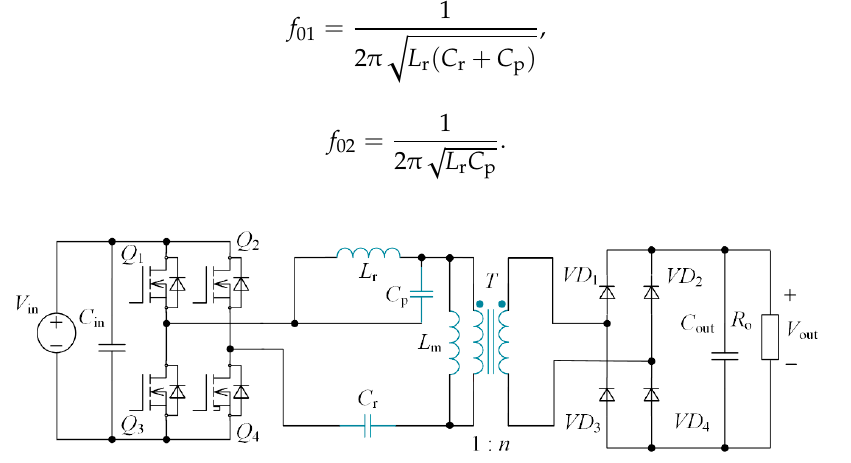
Figure 5. The topology of the LCCL resonant converter.